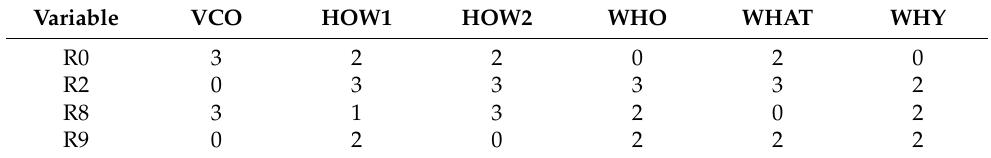
The level of change in the tightness of individual relationships between the BM elements and CE strategies is expressed in | r t − r t * |. The overall level of change of each